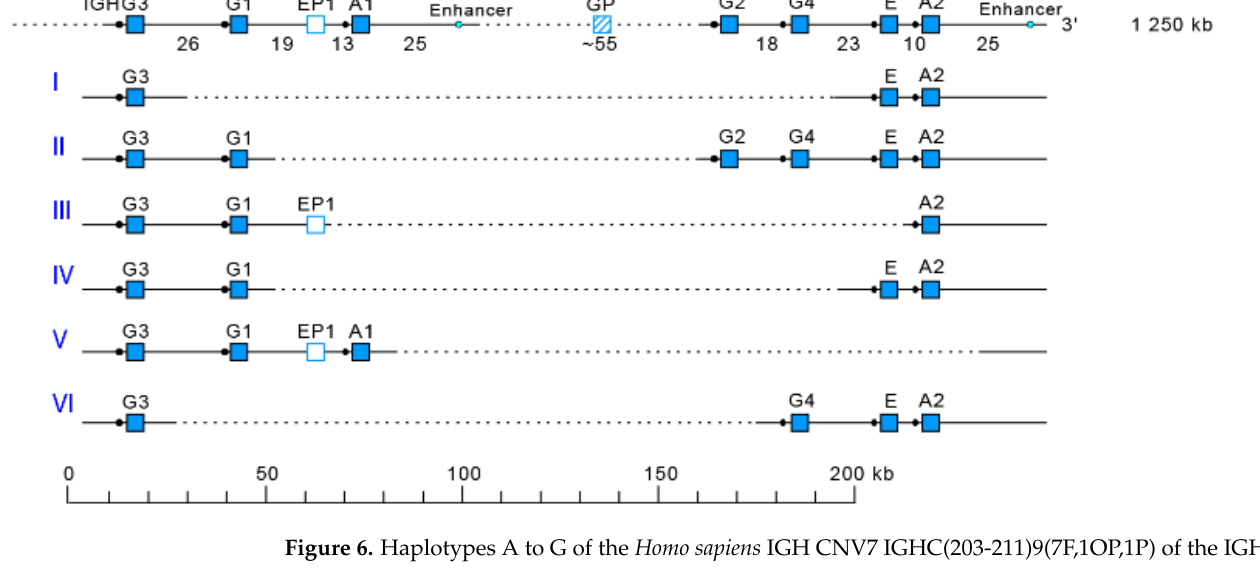
Figure 6. Haplotypes A to G of the Homo sapiens IGH CNV7 IGHC(203-211)9(7F,1OP,1P) of the IGH locus on chromosome 14 (14q32.33) [2,5]. The top line corresponds to haplotype A. The multigene deletions I to VI [142–148] correspond to the CNV7 haplotypes B to G (Table 4). (IMGT ® http://www.imgt.org (accessed on 20 February 2022), IMGT Web resources > IMGT Repertoire (IG and TR) > 1. Locus and genes > 2. Locus representation > IGH: > Human IGHC multigene deletions in healthy individuals http://www.imgt.org/IMGTrepertoire/LocusGenes/locus/human/IGH/multigeneIGHC.html (accessed on 20 February 2022). (With permission from M-P. Lefranc and G. Lefranc, LIGM, Founders and Authors of IMGT ® , the international ImMunoGeneTics information system ® , http://www.imgt.org) (Accessed on 20 February 2022).